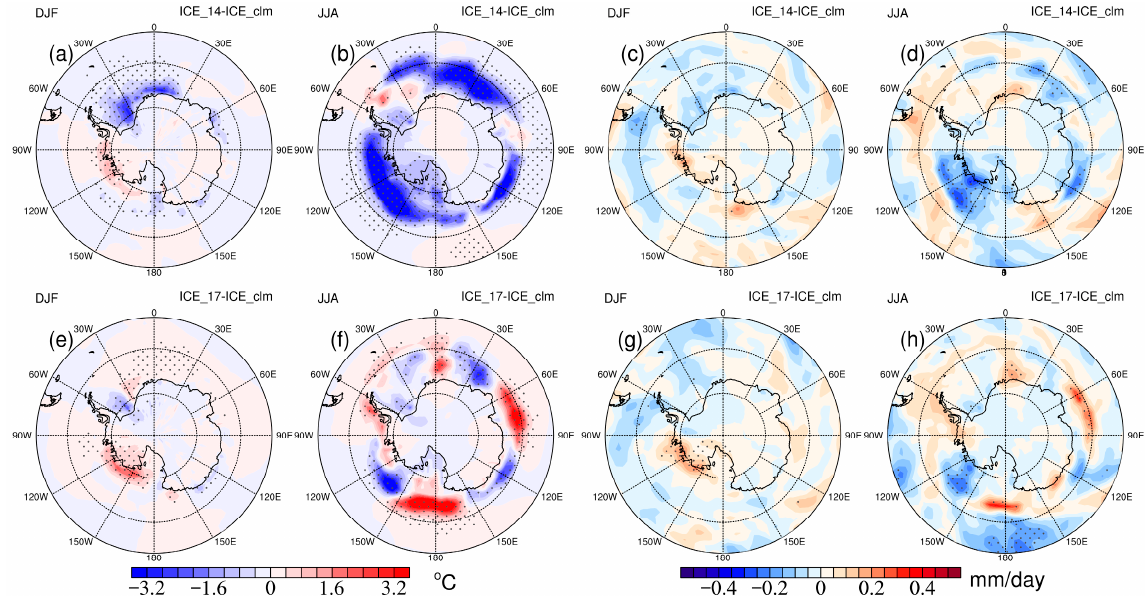
Figure 6. Changes in the 2-m temperature and precipitation as a result of changes in Antarctic sea ice. Temperature responses of ICE_14 in ( a ) summer and ( b ) winter. Precipitation responses of ICE_14 in ( c ) summer and ( d ) winter. Temperature responses of ICE_17 in ( e ) summer and ( f ) winter. Precipitation responses of ICE_17 in ( g ) summer and ( h ) winter. Dotted areas indicate statistical significance at the 95% confidence level.